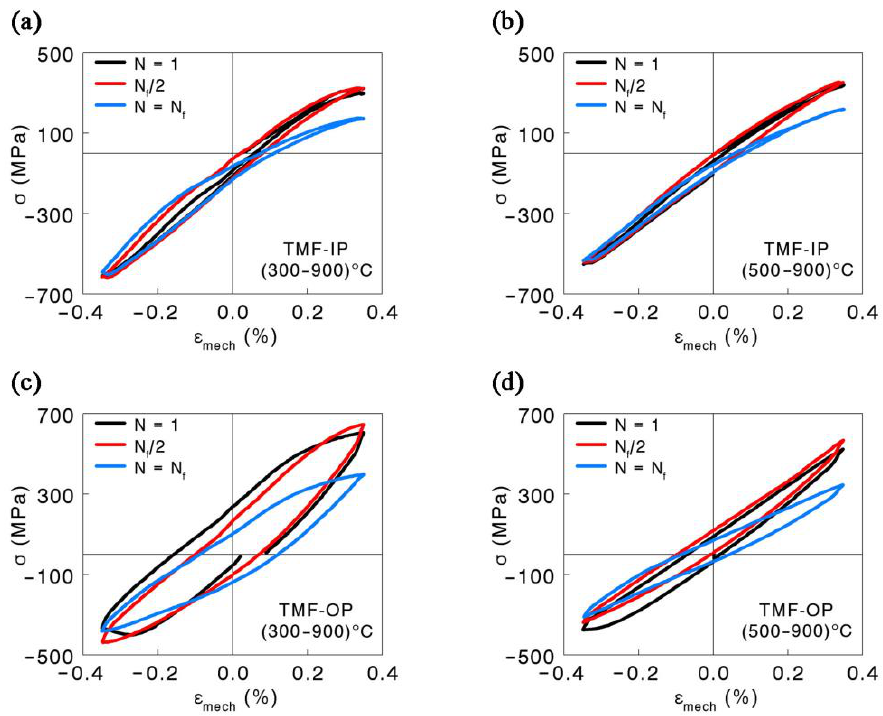
Figure 6. Representative hysteresis loops ( a ) IP 300 – 900°C ( b ) IP 500 – 900 °C ( c ) OP 300 – 900 °C ( d ) OP 500 – 900 °C.